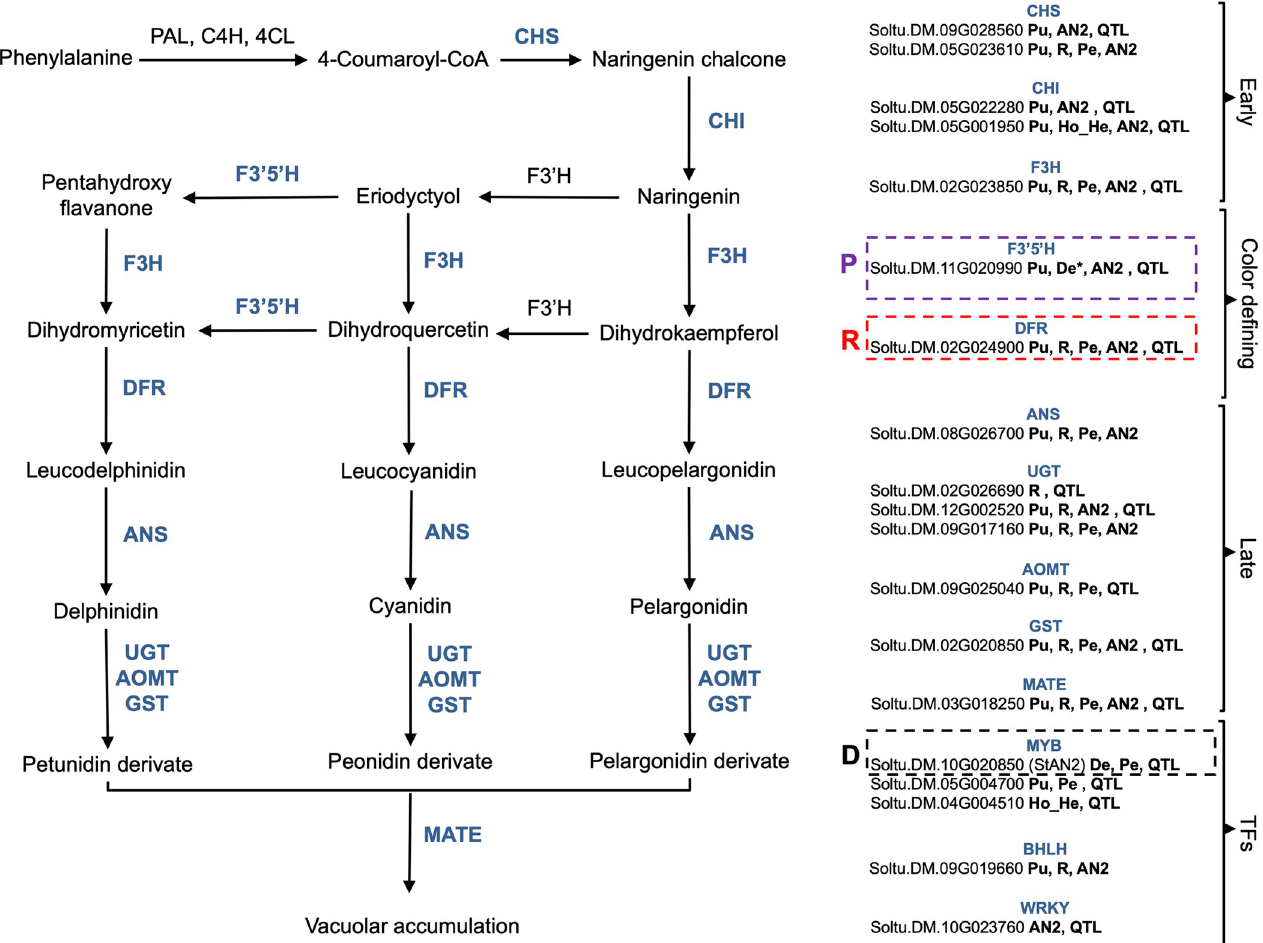
Fig 4. DEG and ExM genes participating in anthocyanin biosynthesis. The left panel shows schematic representation of the most important enzymatic reactions involved in anthocyanin biosynthesis. Enzymes identified among DEG or ExM genes are indicated in blue and displayed in the right panel. The right panel presents information on the different genes associated to each enzymatic function. The causal genes at the P, R and D loci are highlighted. The code of the different genes is indicated as well as significant status in different analyses: Pu: DEG purple vs light; R: DEG red vs light; De: ExM delphinidin the � indicates a marginally significant FDR = 0.11; Pe: ExM peonidin; StAN2: coexpressed with StAN2 ; QTL: located in mQTL.